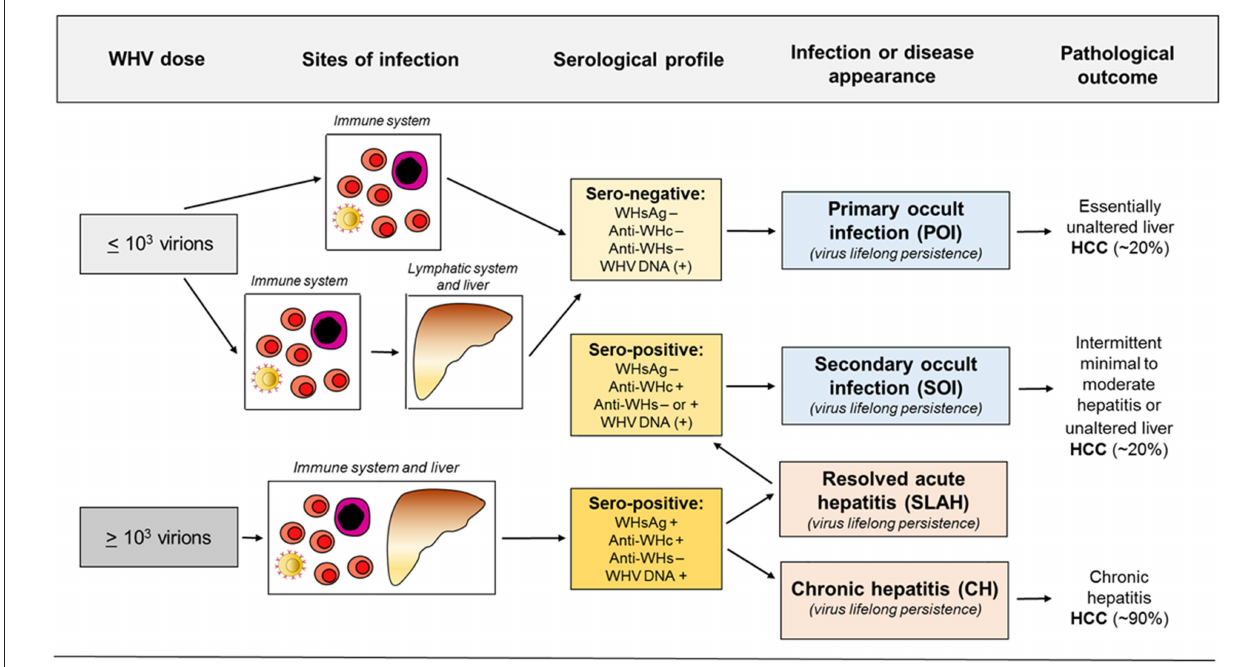
FIGURE 2 | Abbreviated concept of the development of occult and overt (symptomatic) WHV infections, sites of replicating virus, and serological appearance and infection outcomes in relation to a dose of invading virus. For details see